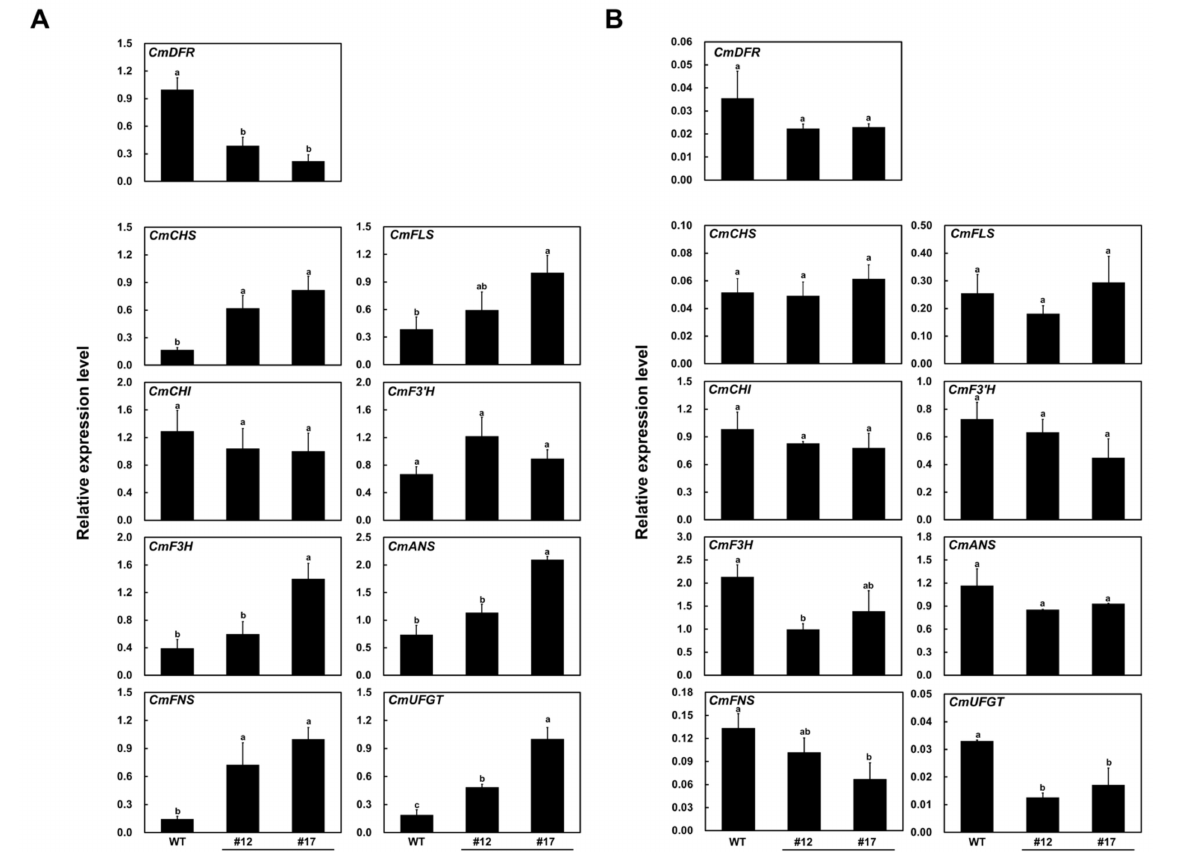
Figure 5. Expression of flavonoid biosynthetic pathway genes in WT and PANS-CmDFR-RNAi transgenic chrysanthemum ray florets ( A ) and leaves ( B ). Biosynthetic pathway genes evaluated: early biosynthetic genes chalcone synthase ( CmCHS ), chalcone isomerase ( CmCHI ), flavanone 3-hydroxylase ( CmF3H ), flavone synthase ( CmFNS ), flavonol synthase ( CmFLS ), and flavonoid 3 (cid:48) -hydroxylase ( CmF3 (cid:48) H ), and the late biosynthetic genes dihydroflavonol 4-reductase ( DFR ), anthocyanidin synthase ( CmANS ), and UDP-glucose: flavonoid 3-O-glucosyltransferase ( CmUFGT ). The chrysanthemum elongation factor 1 α ( CmEF1 α ) gene was used as a reference gene to normalize target gene expression. All results represent mean values ± SD from three independent biological replicates. Different letters above the bars indicate significantly different values ( p < 0.01, one-way ANOVA followed by Duncan’s multiple range test).